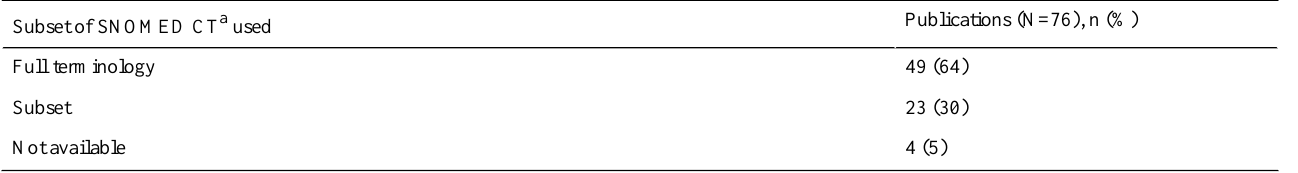
Table 8. Subset of Systematized Nomenclature of Medicine Clinical Terms used in publications.